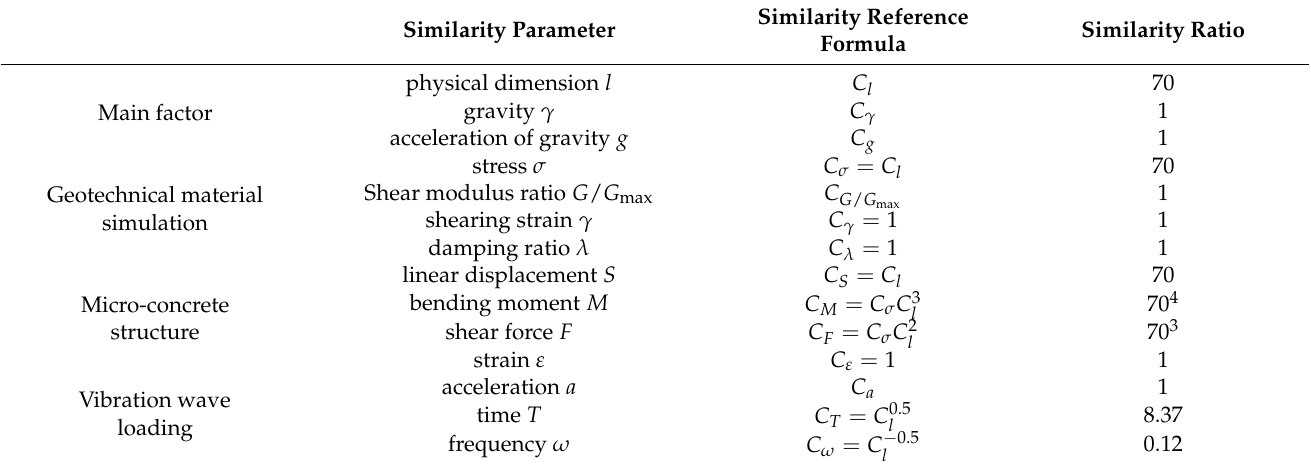
Table 1. Similarity ratio of model’s physical